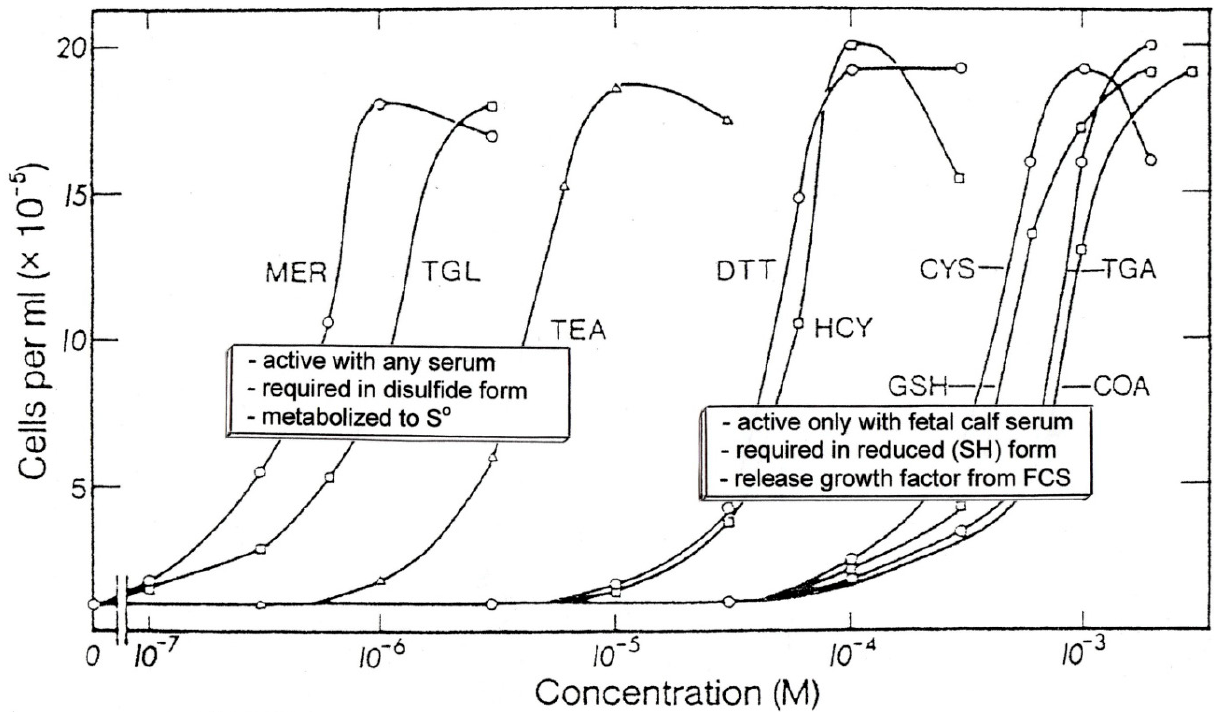
Figure 3. Growth response of P388 leukemia cells in vitro to various sulfur